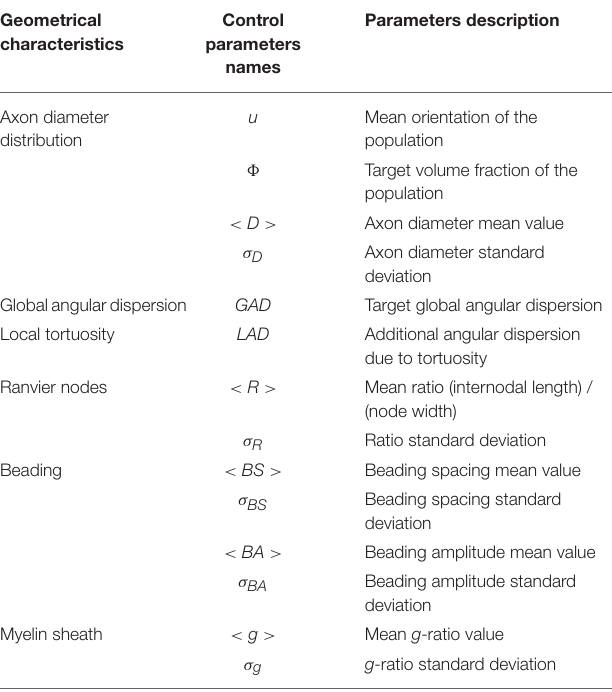
TABLE 1 | List of control parameters names associated to each step of the phantom generation algorithm. Geometrical